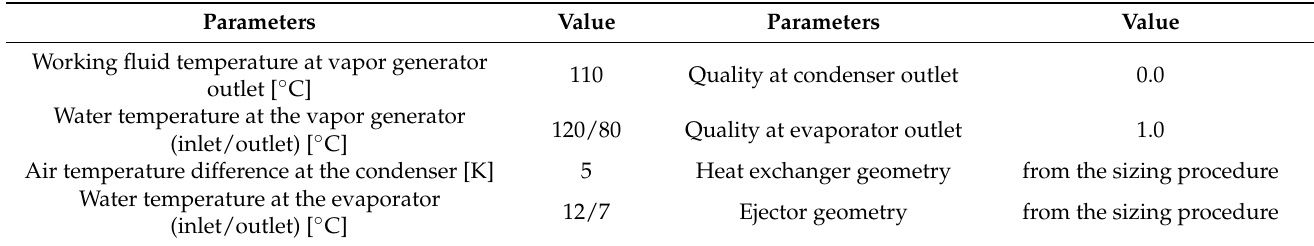
Table 5. Specifications of the boundary conditions used for the seasonal simulation process.